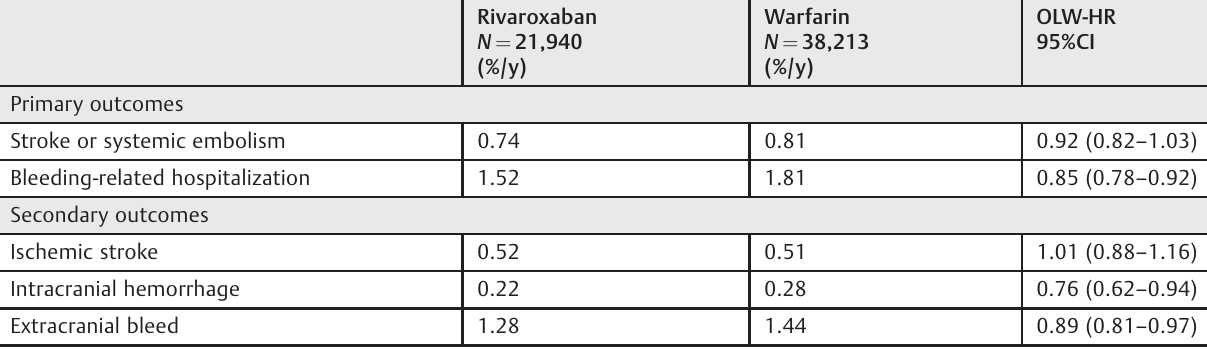
Table 2 Effectiveness and safety outcomes